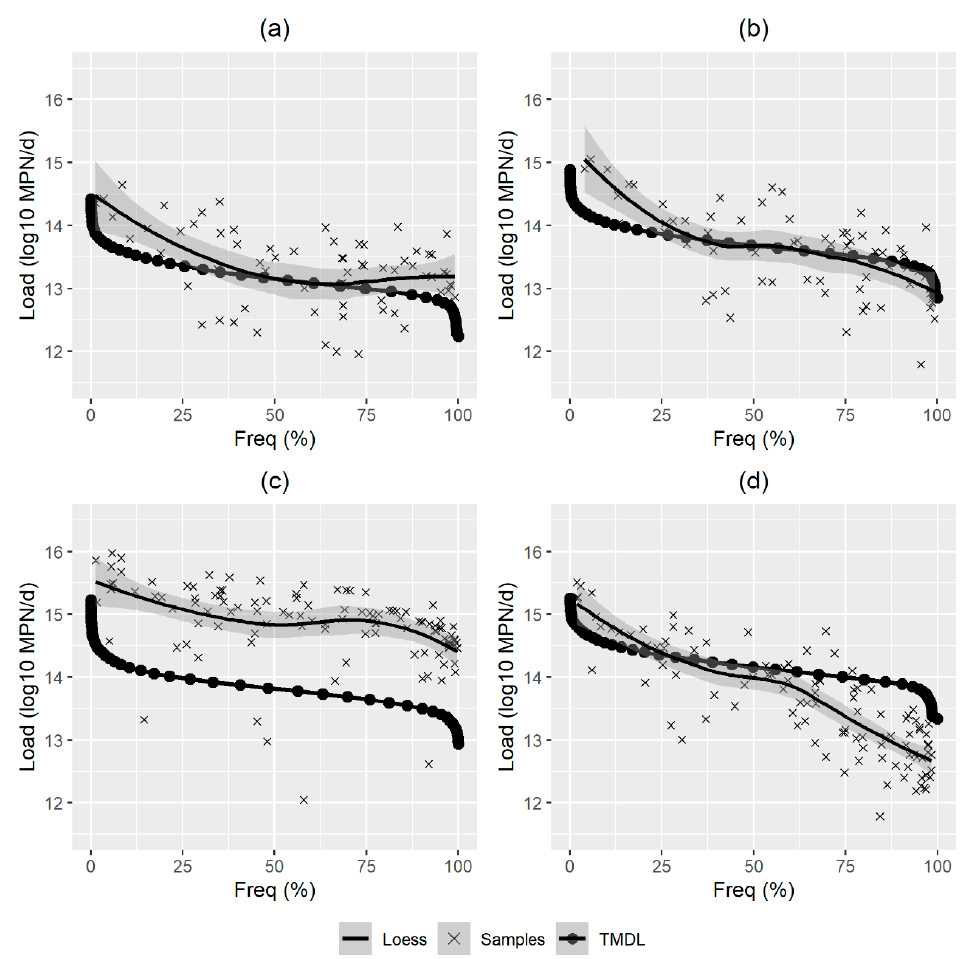
Figure 7. Comparison between load duration curves (TMDL) and Loess curve (representing the tendency of E. coli samples) in the Piranga river basin: Gauge ( a ) 56028000/RD001, ( b ) tendency of E. coli samples) in the Piranga river basin: Gauge ( a ) 56028000 / RD001, ( b ) 56075000 / RD007, 56075000/RD007, ( c ) 56110005/RD013 and ( d ) 56539000/RD023. ( c ) 56110005 / RD013 and ( d ) 56539000 /